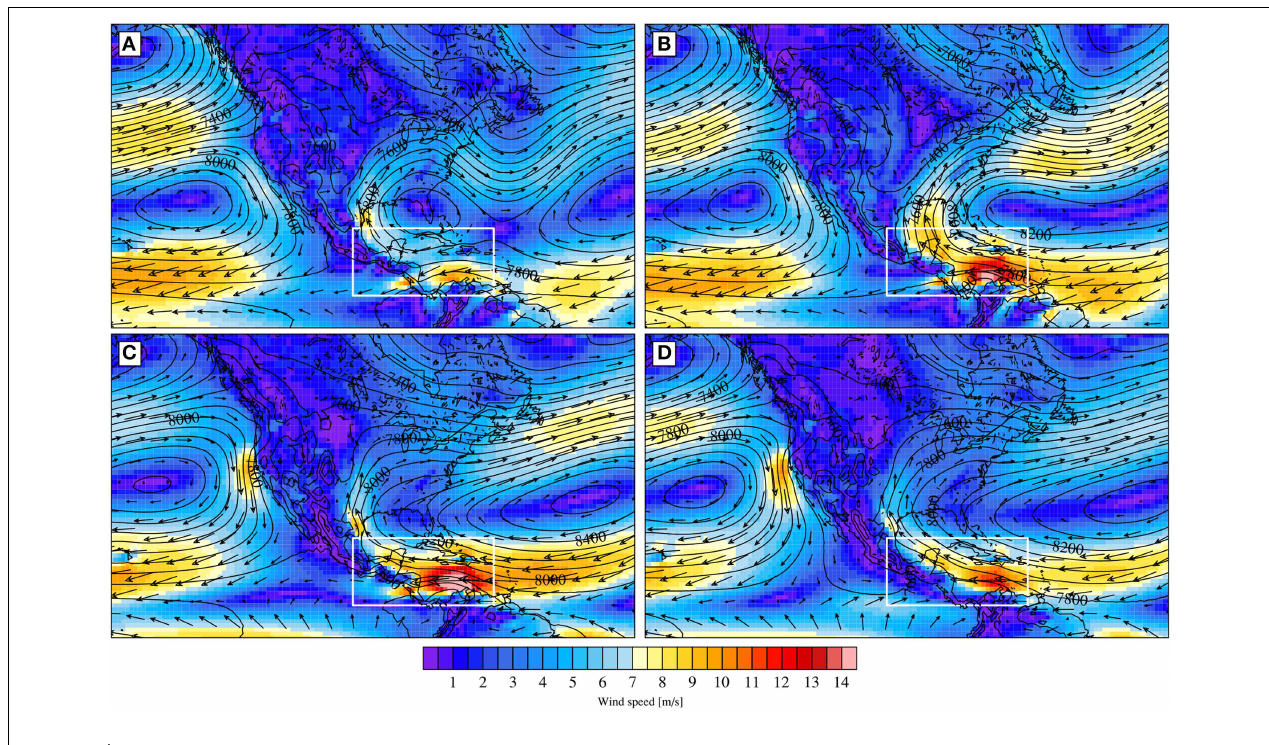
FIGURE 5 | Composited large-scale patterns at 925 hPa associated with (A) SPAG, (B) SPNW, (C) SLLJ, and (D) SMWR regimes. Geopotential height [ m 2 / s 2 ] (black contours), wind speed